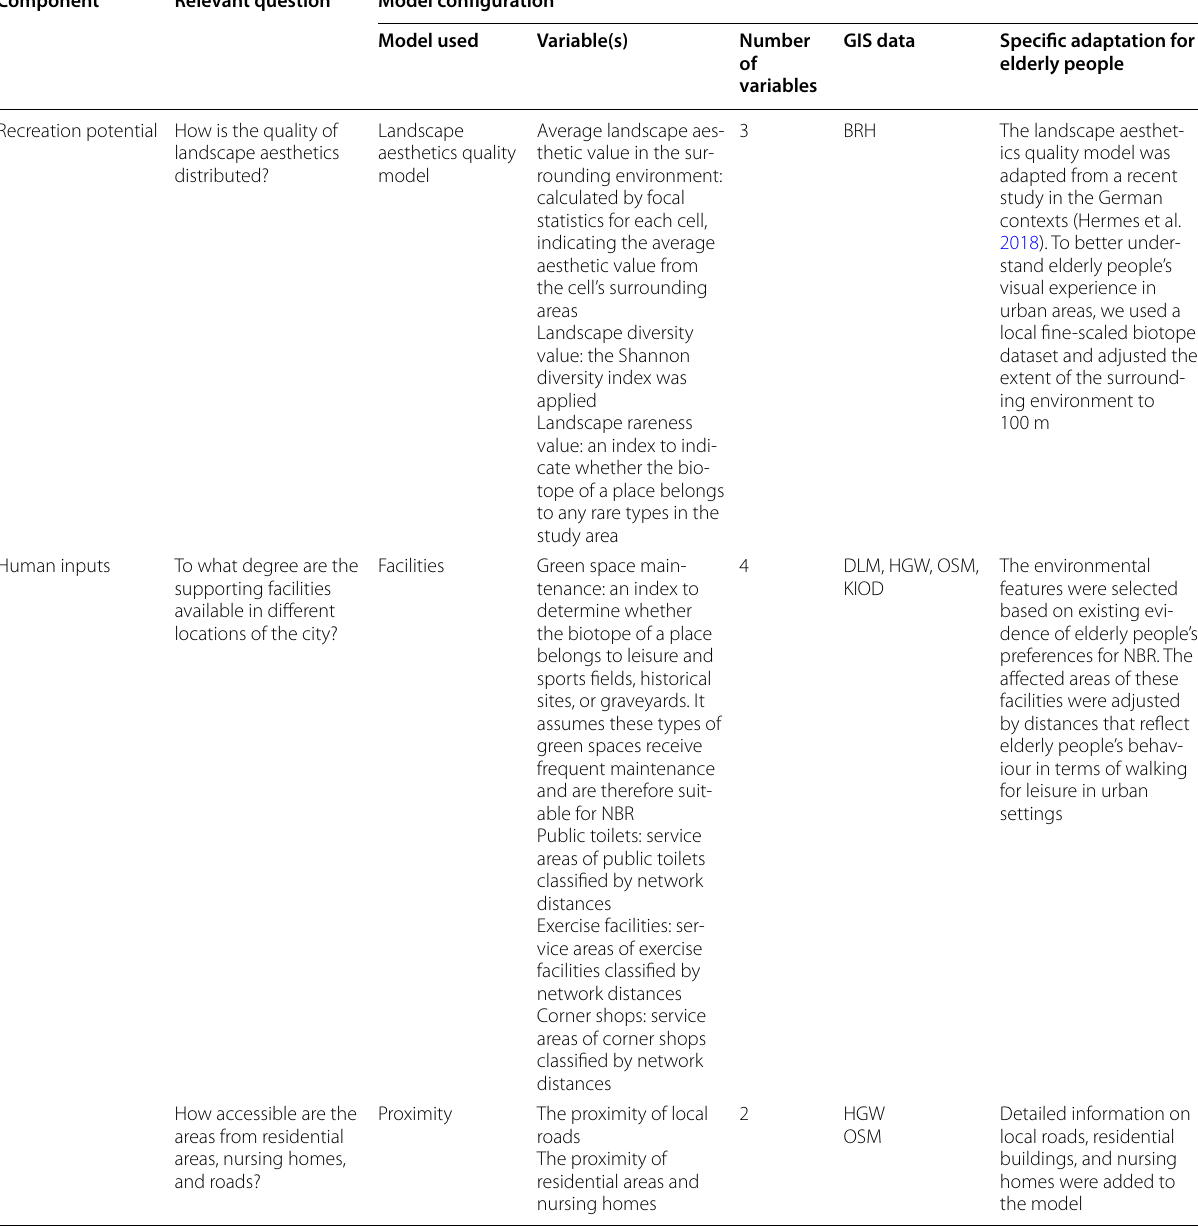
Table 3 Model components, configuration, and data used to study recreation